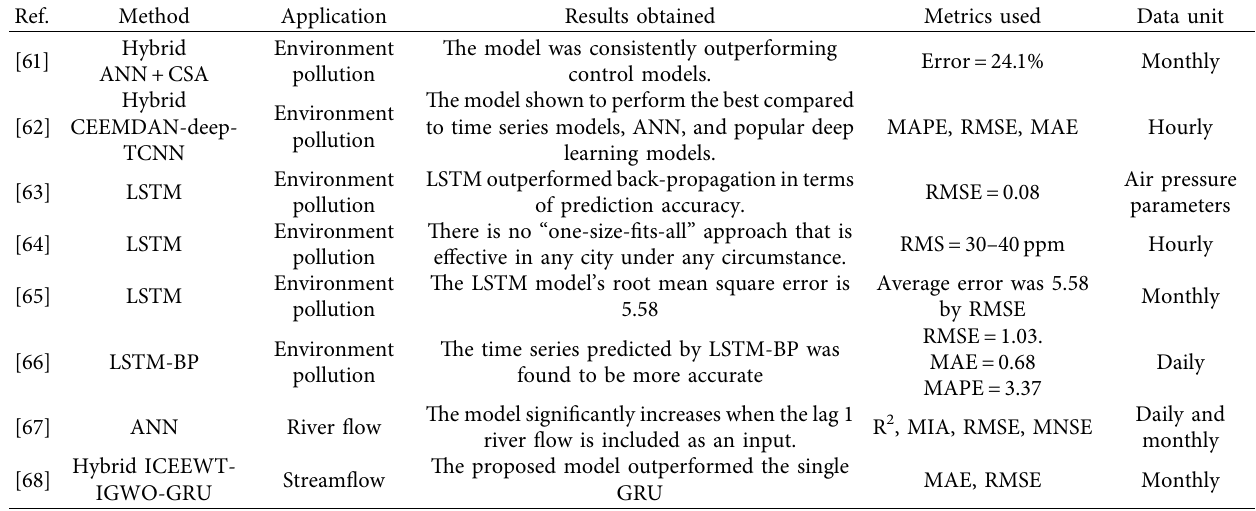
Table 3: A summary of published articles that used deep sequential models in environment and pollution predictions.